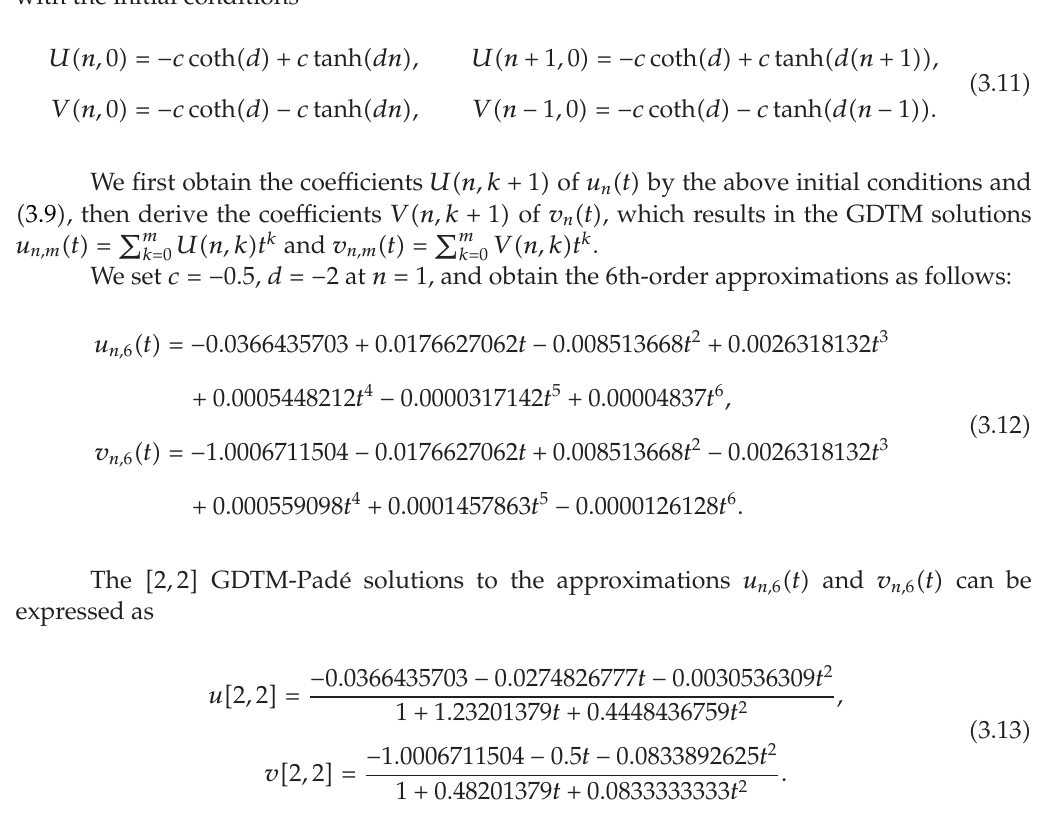
with the initial